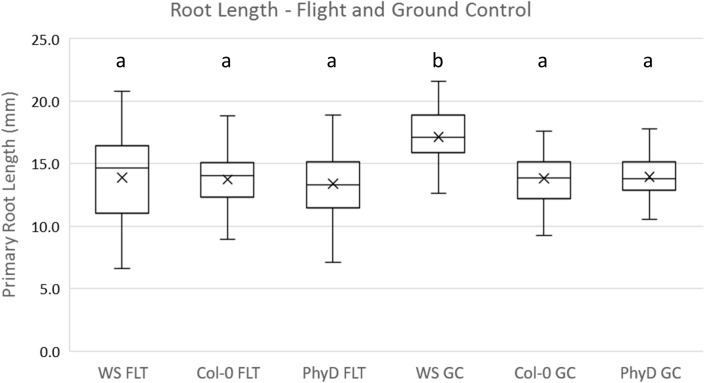
The root lengths among genotypes grown on orbit were not significantly different from one another.The box for each genotype/treatment combination contains a line indicating the median, and an "x" indicating the mean. Above each box is a designation of the results of Tukey’s Honestly Significant Difference, following the two-way ANOVA, where shared letters indicate insignificant difference. Only one of the six sample sets (WS.GC) was different from the other five.